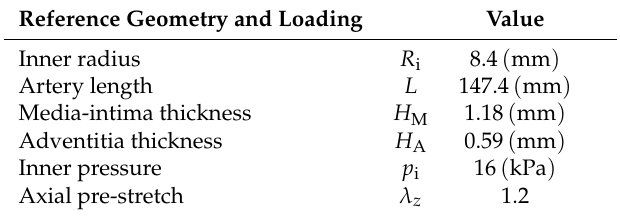
Table 1. Reference set of parameters to model Abdominal Aortic Aneurysm (AAA)